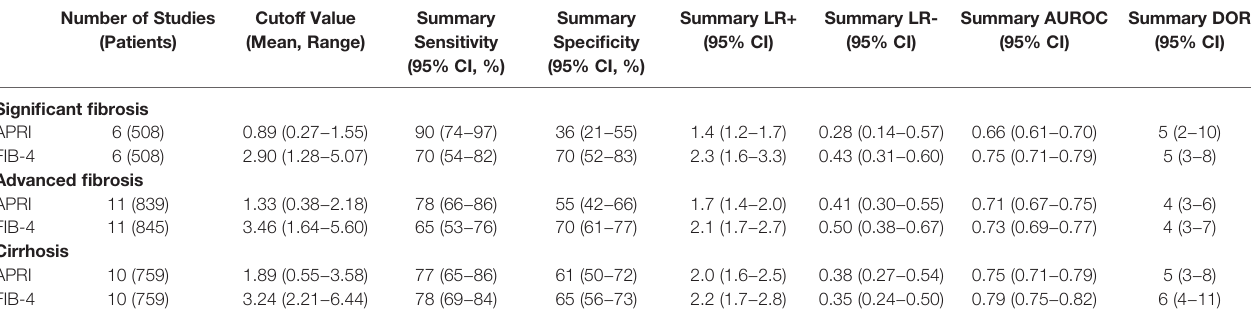
TABLE 3 | Meta-analysis results of APRI and FIB-4 for prediction of signi fi cant fi brosis, advanced fi brosis and cirrhosis in AIH. Number of Studies Cutoff Value Summary (Patients) (Mean, Range)